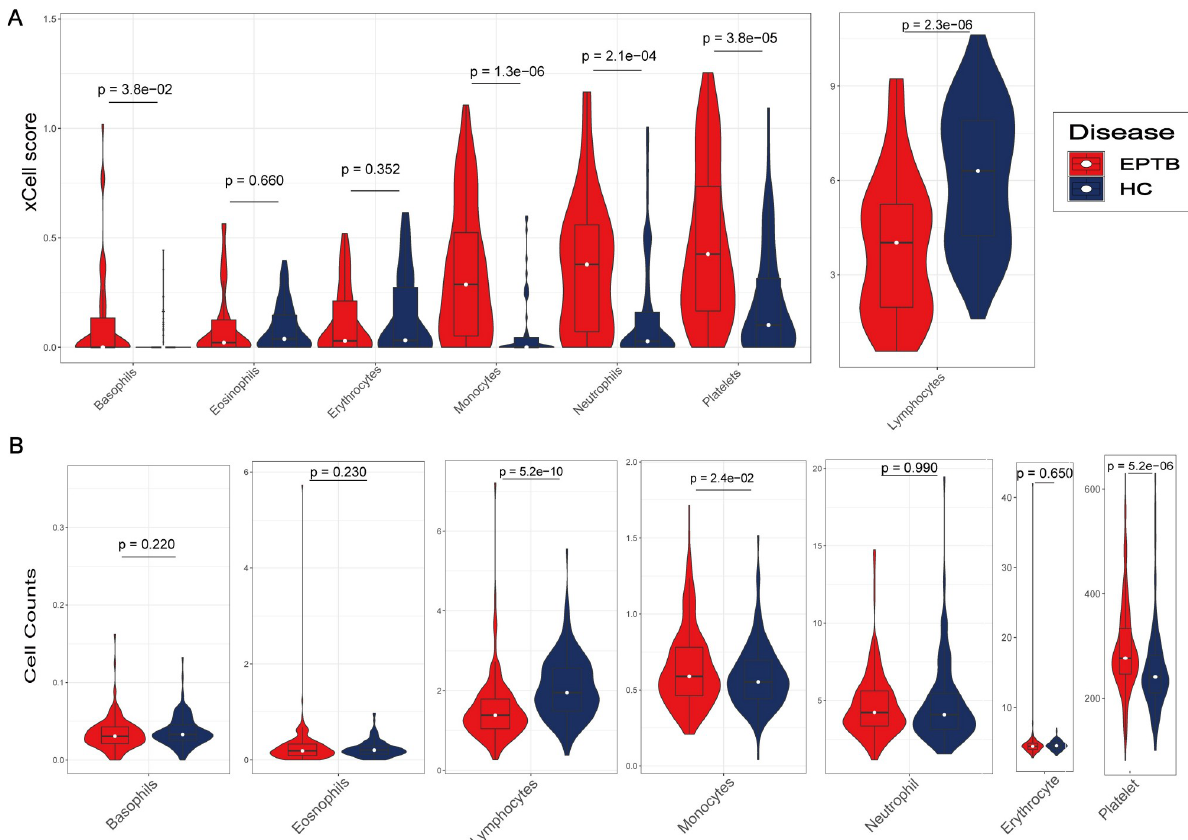
Fig 1. Different cell type between EPTB and healthy controls. (A) Violin plot showed the xCell score of 7 kinds of blood cells in dataset GSE83456. (B) Violin plot showed the cell counting of 7 kinds of blood cells in clinical data. (C) Violin plot showed the cell rate of 5 kinds of blood cells in clinical